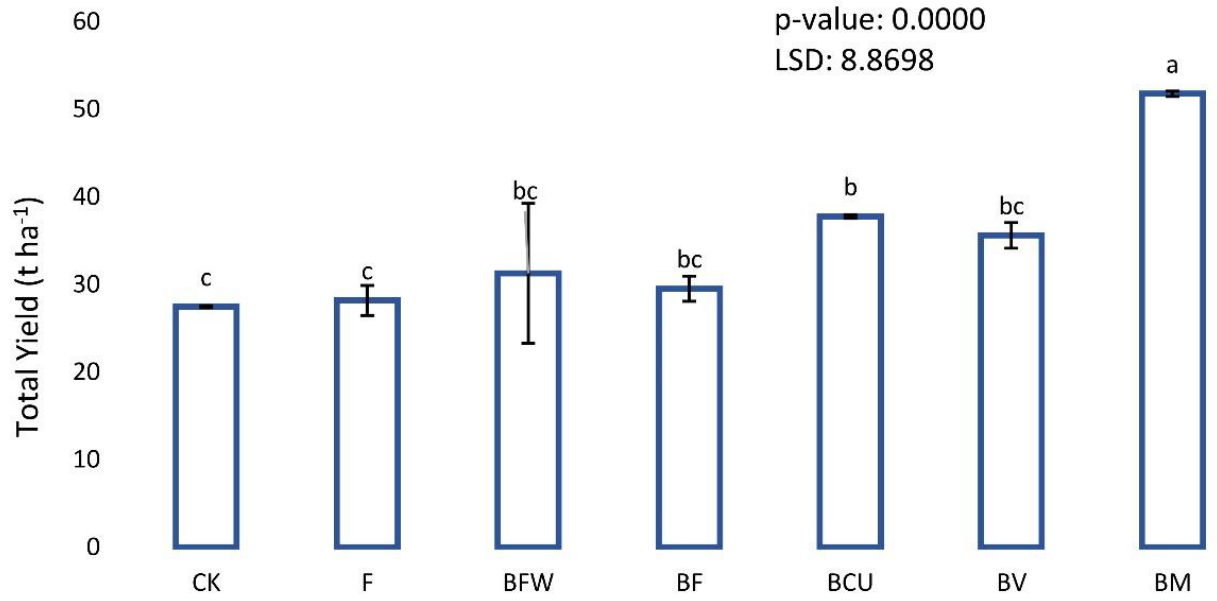
Figure 3. Total fruit yield of okra in different biochar mixed or enriched mineral (NPK) and organic